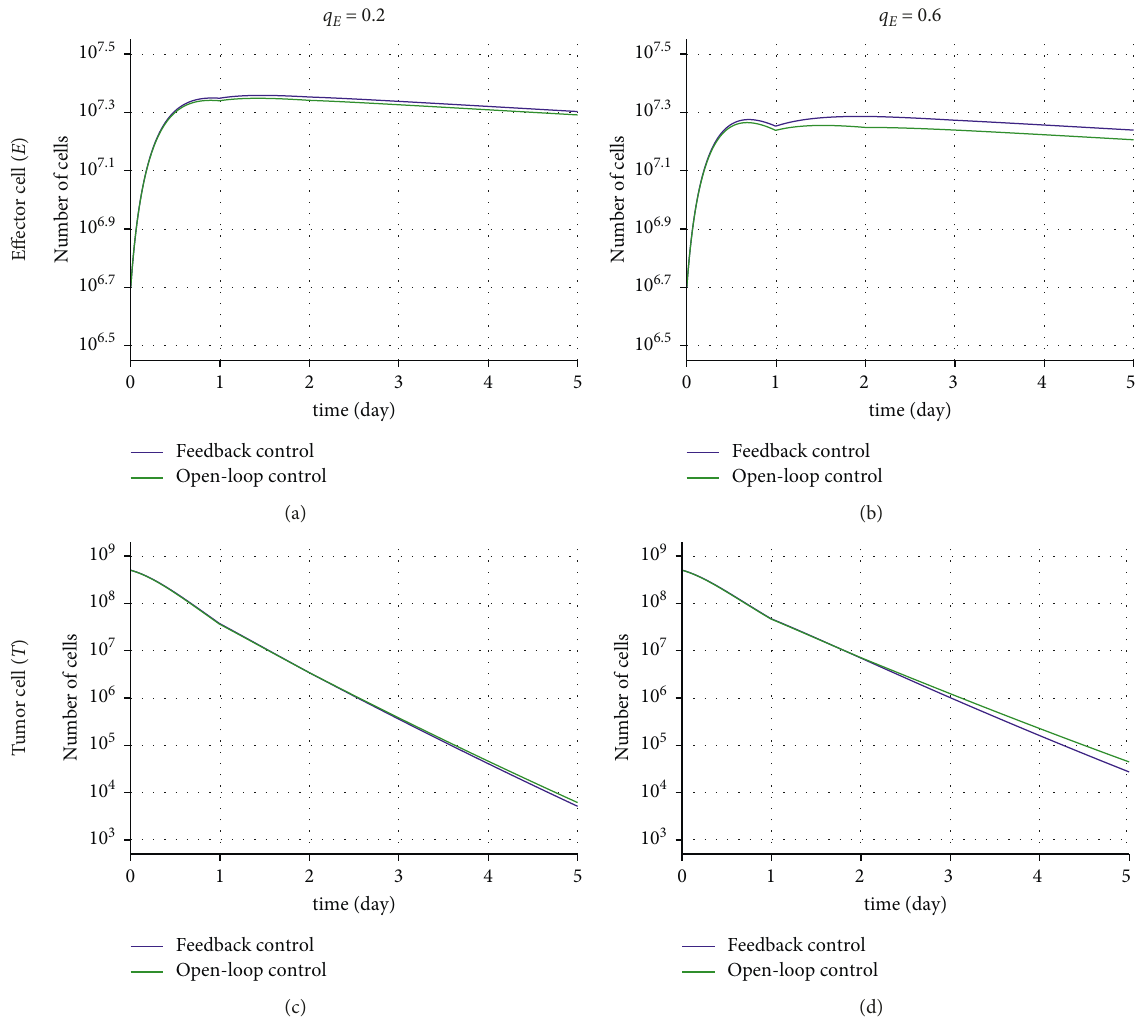
Figure 4: Numerical simulations of tumor-immune model (1) with chemotherapy. The blue line means the feedback control and the green line represents the open-loop control. The upper panels indicate the number of effector cells for q E � 0 . 2 (a) and q E � 0 . 6 (b), respectively. The lower panels indicate the number of tumor cells for q E � 0 . 2 (c) and q E � 0 . 6 (d), respectively. The initial values are assumed to be ( E ( 0 ) ,T ( 0 )) � ( 5 . 0 × 10 6 , 5 . 0 × 10 8 )